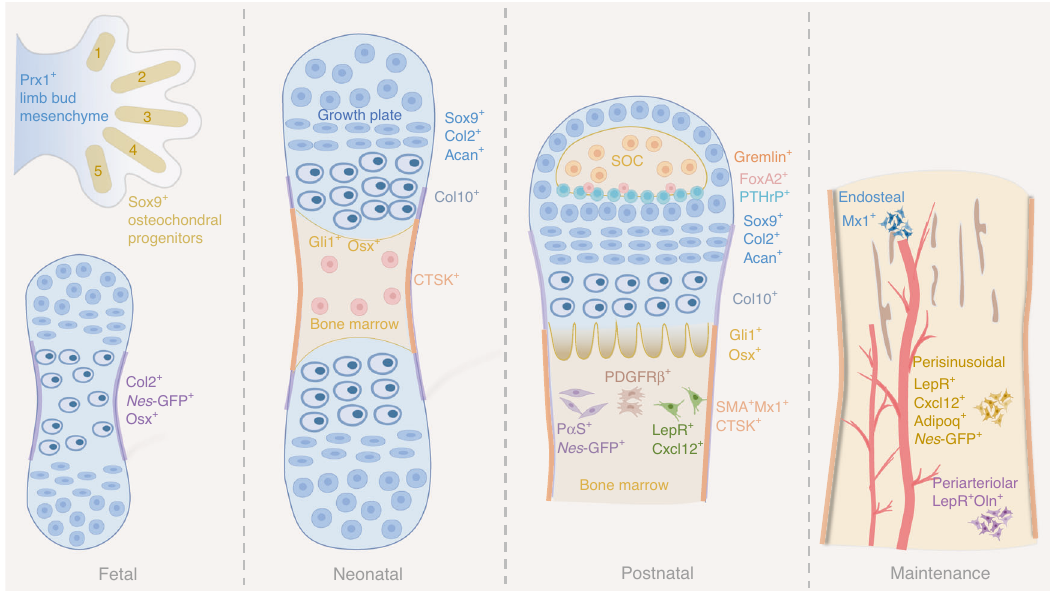
Fig. 1 Schematics of skeletal stem cells and progenitors in mouse long bone. At fetal stage, limb bud mesenchymal cells express Prx1 and osteochondral progenitors are Sox9 + . When fetal growth plate forms, Col2, Nes -GFP, and Osx mark progenitors at perichondrium. Neonatal long bone harbors various types of SSCs and progenitors, including Sox9 + /Col2 + /Acan + /Col10 + cells at growth plate, Gli1 + /Osx + cells at primary spongiosa, Ctsk + cells at periosteum and Ranvier ’ s groove. Postnatal long bone is occupied with long-term SSCs and progenitors, including Grem1 + /FoxA2 + /PTHrP + /Sox9 + /Col2 + /Acan + /Col10 + cells at epiphysis and growth plate cartilage, Gli1 + /Osx + cells at primary spongiosa, PDGFR β + /P α S + / Nes -GFP + /LepR + /Cxcl12 + cells in bone marrow, and α SMA + Mx1 + /Ctsk + cells at periosteum. Adult bone marrow is highly complex and contains endosteal, perisinusoidal, and periarteriolar niches, which harbor tissue-resident SSCs and progenitors essential for hematopoietic